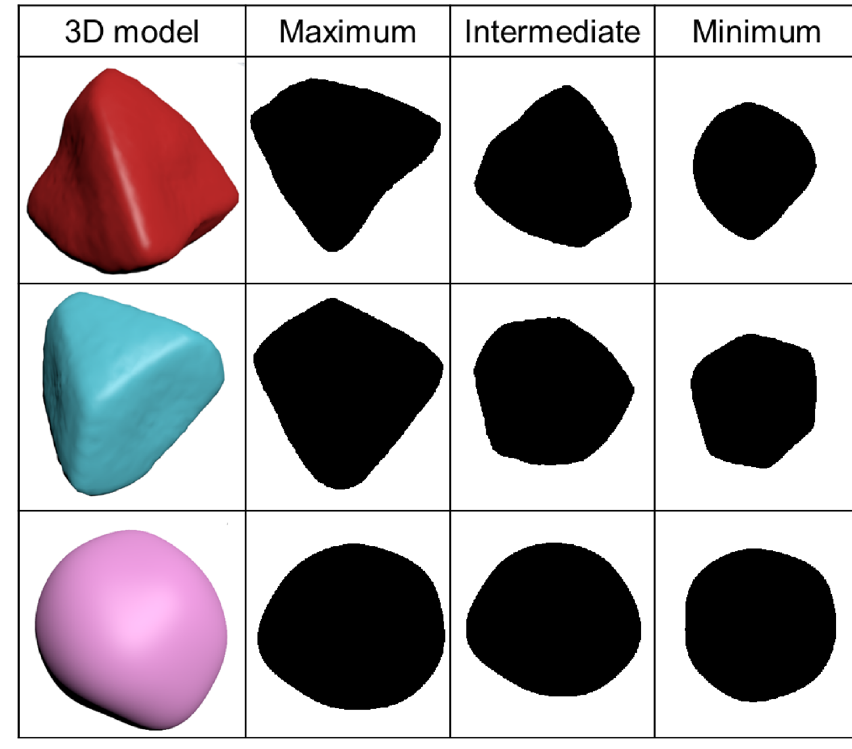
Fig. 4 Examples of 3D particles and their 2D projections based on stereology